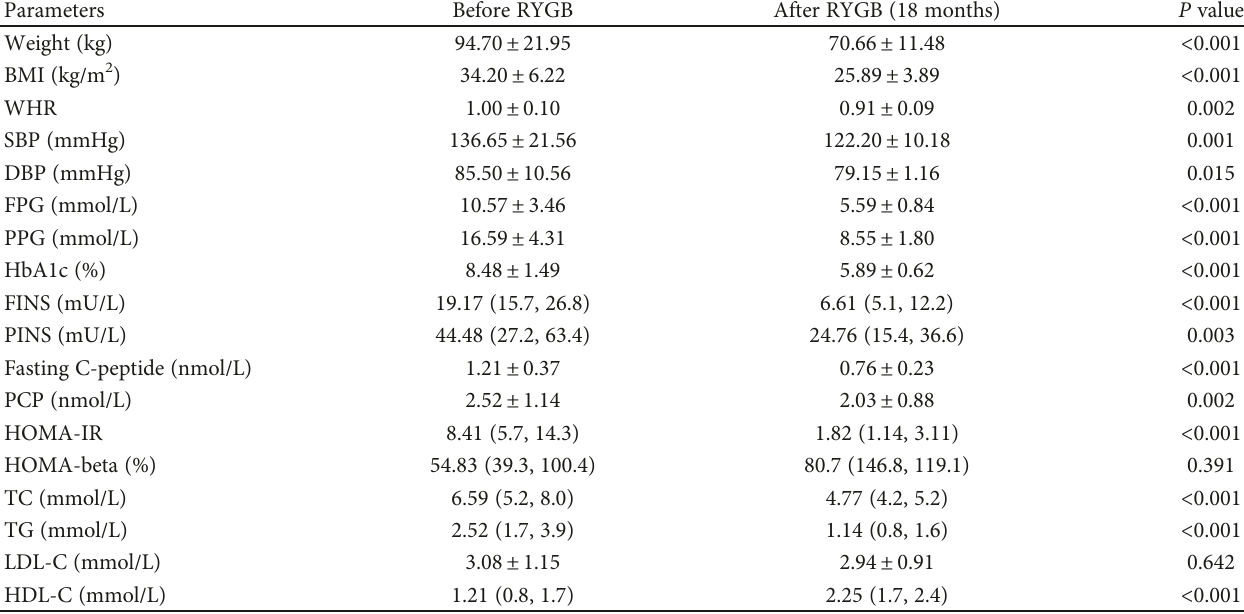
Table 2: Changes of cardiometabolic factors before and after RYGB ( n = 20 ).